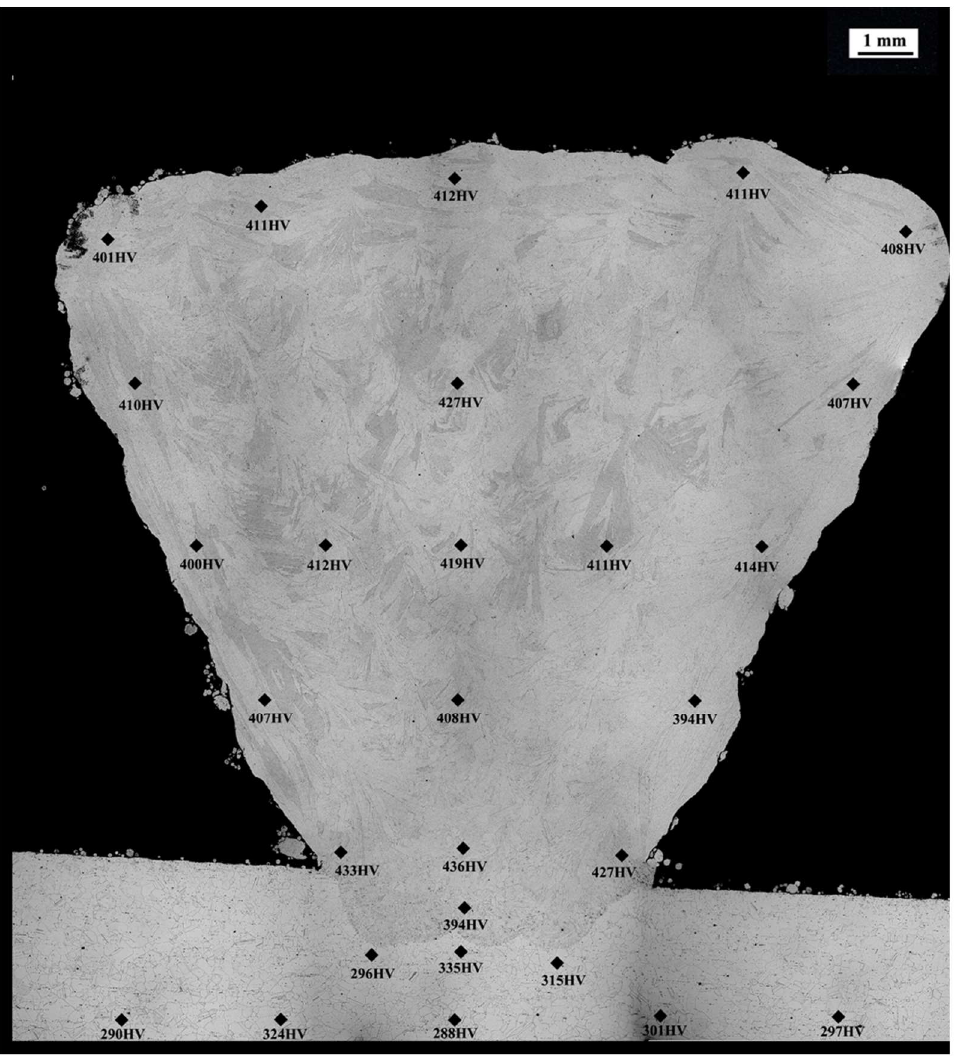
Figure 9. Hardness profile of the STA sample. Table 5. HV hardness in top, middle, first layer, and substrate of all samples.